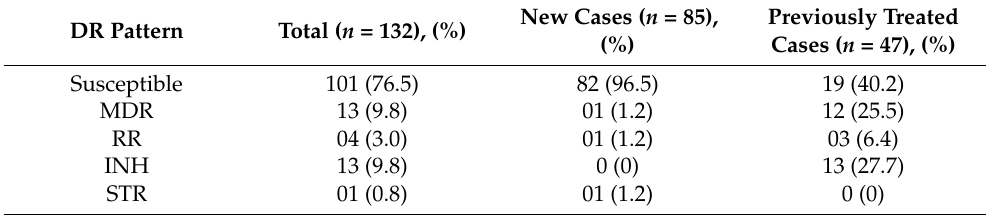
Table 4. First-line drug-resistant patterns among new and previously treated cases (N = 132).